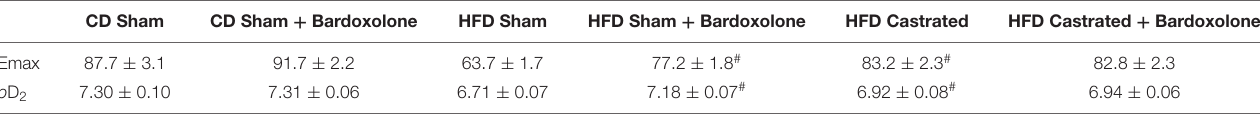
Frontiers in Physiology |